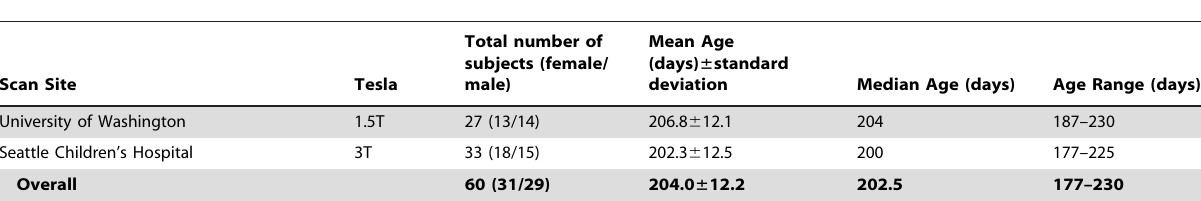
Table 1. Demographics of the subjects included in the average head template.